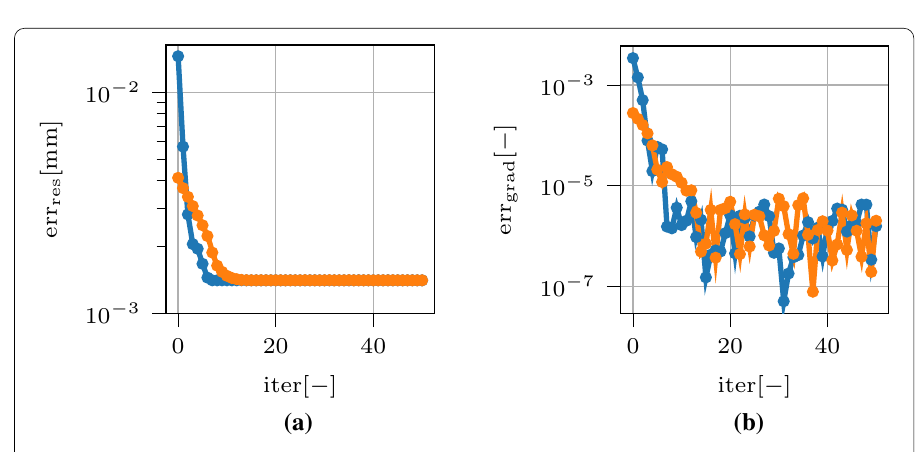
Fig. 13 Errors for inverse analysis with homogeneous assumption on heterogeneous reference results with different initial guesses